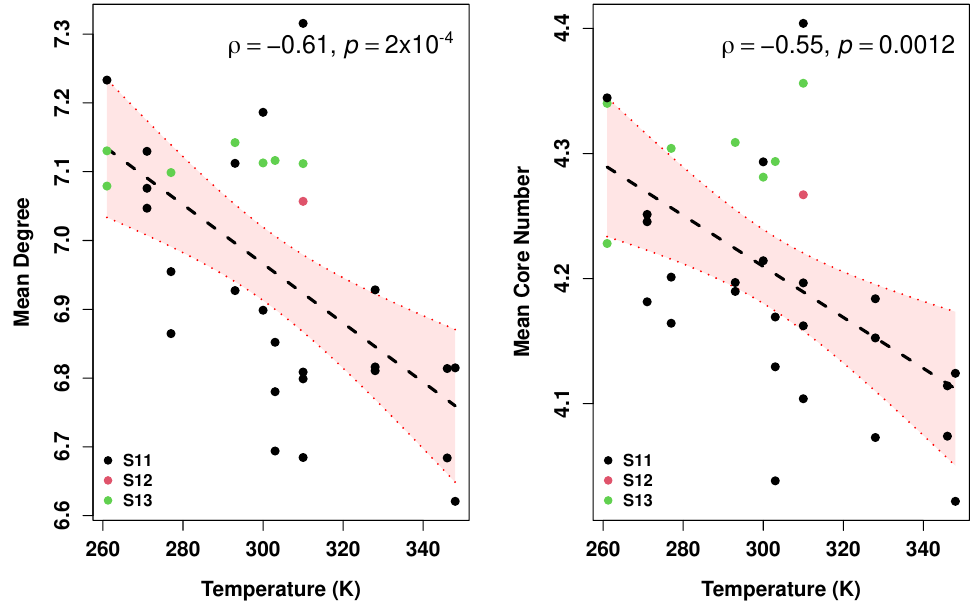
Figure 9. PSN cohesion by temperature, as assessed by mean degree ( left ) and mean core num- ber ( right ). OLS fit shown by central line; the shaded area indicates the 95% confidence bands. For both measures, we see a significant decline in cohesion for proteins with higher observed environmental